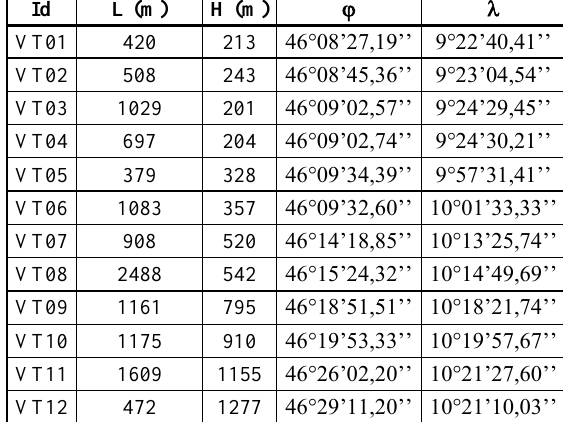
Table 4 . Positions of the RTK study-areas. L: length of the path, H: orthometric height,  : mean ITRF2008 latitude and longitude of the